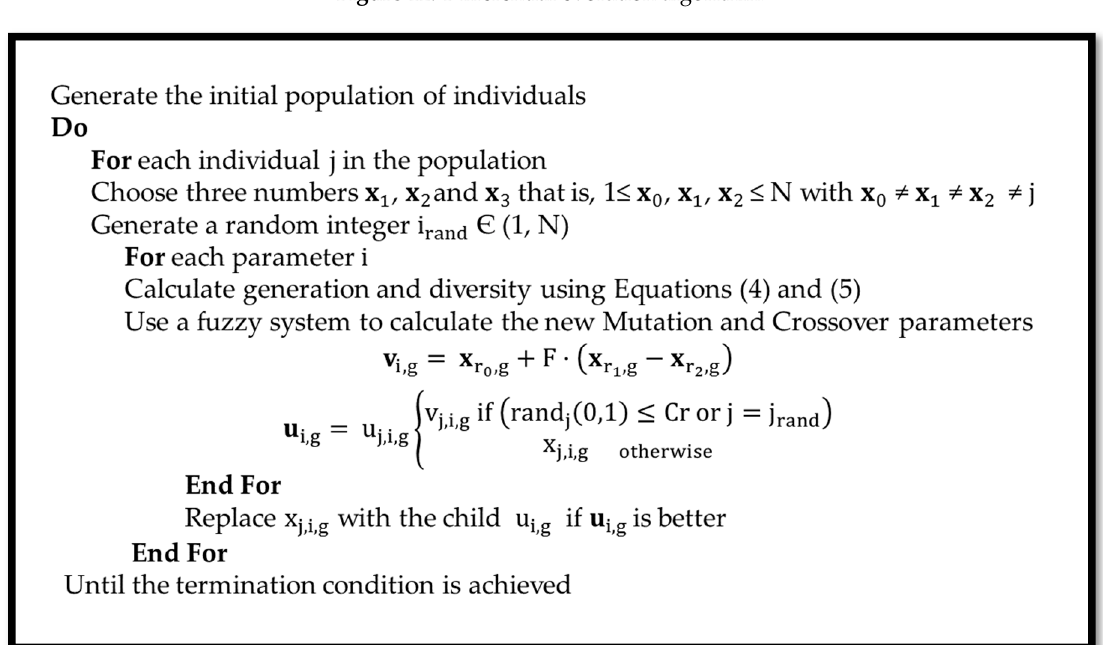
Figure 13. Fuzzy differential evolution algorithm.